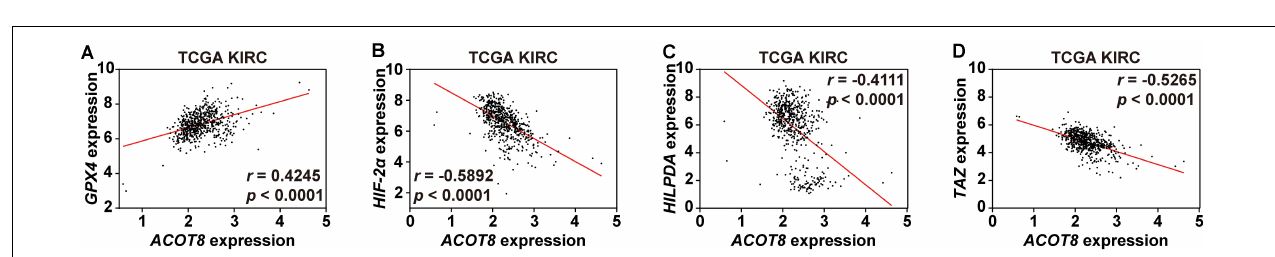
FIGURE 7 | Significantly enriched gene sets in high ACOT8 samples. GSEA was performed to compare the expression profiles between high ACOT8 and low ACOT8 samples from TCGA database, and four gene sets were significantly enriched in high ACOT8 samples at nominal p < 0.05, FDR < 0.25, and |NES| > 1.0 (A–D) .